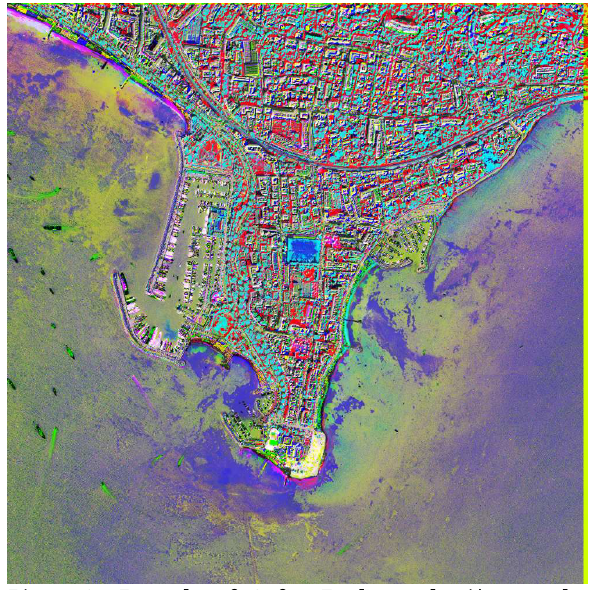
Figure 3. Example of Orfeo ToolBox algorithm results: MAD/MAF analysis (Nielsen et al., 2010) on a pair of 4 bands Worldview2 images of Cannes,